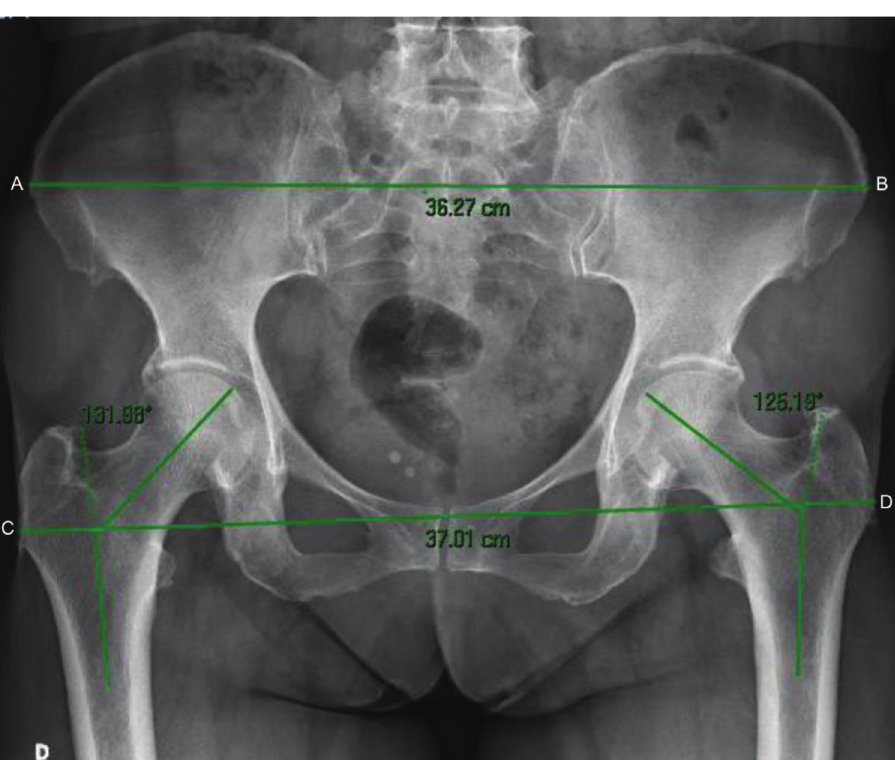
Figure 1 - Distances between the greater trochanter and iliac crest and demonstration of the measurement of the femoral neck–shaft angle. AB, distance between the external lateral ends of the iliac crest; CD, distance between the most lateral ends of the greater trochanters; CD/AB, pelvic–trochanteric index.